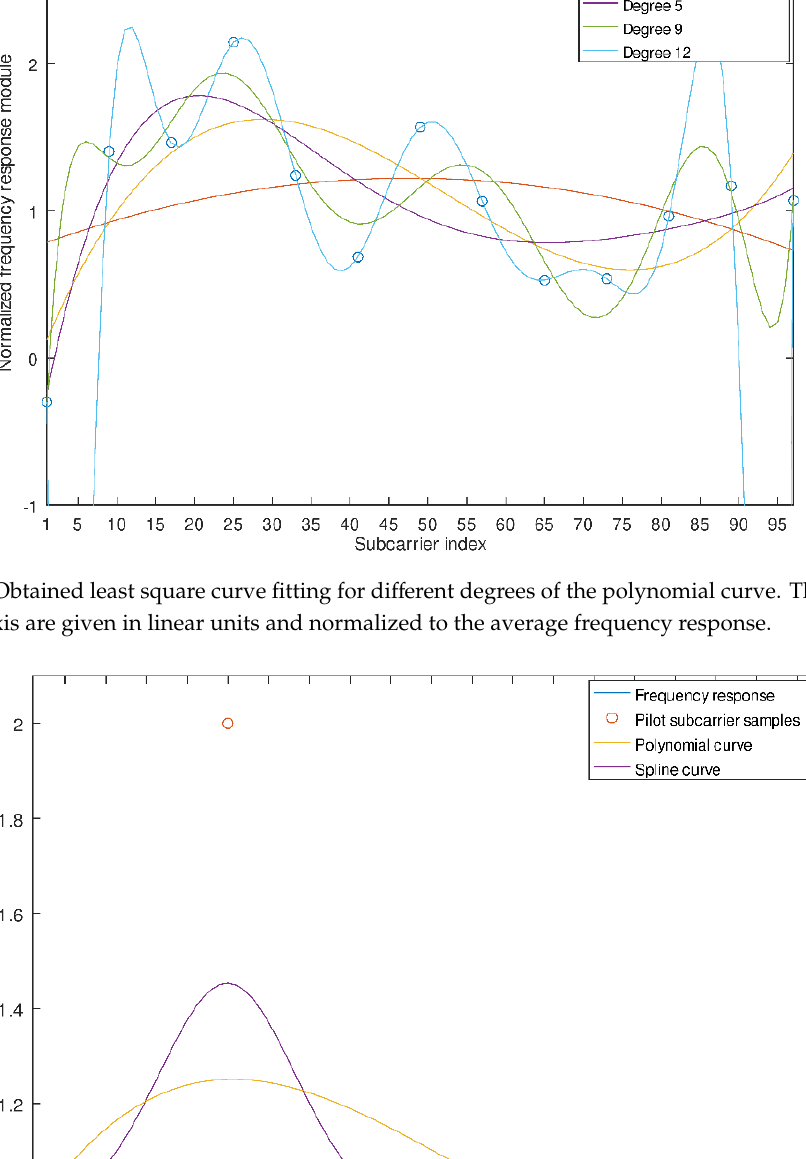
Figure 1. Obtained least square curve fitting for different degrees of the polynomial curve. The values in the Y -axis are given in linear units and normalized to the average frequency response.